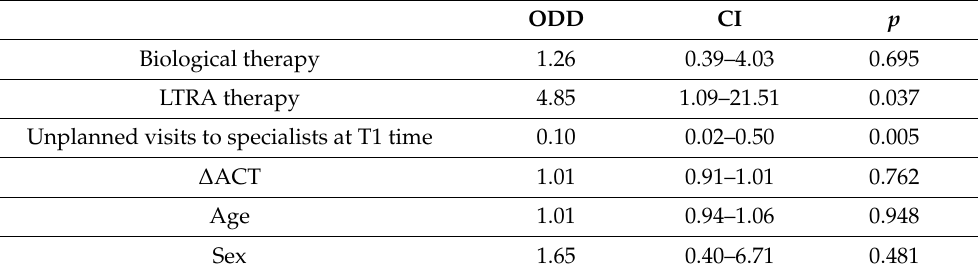
Table 5. Prediction of FeNO reduction.